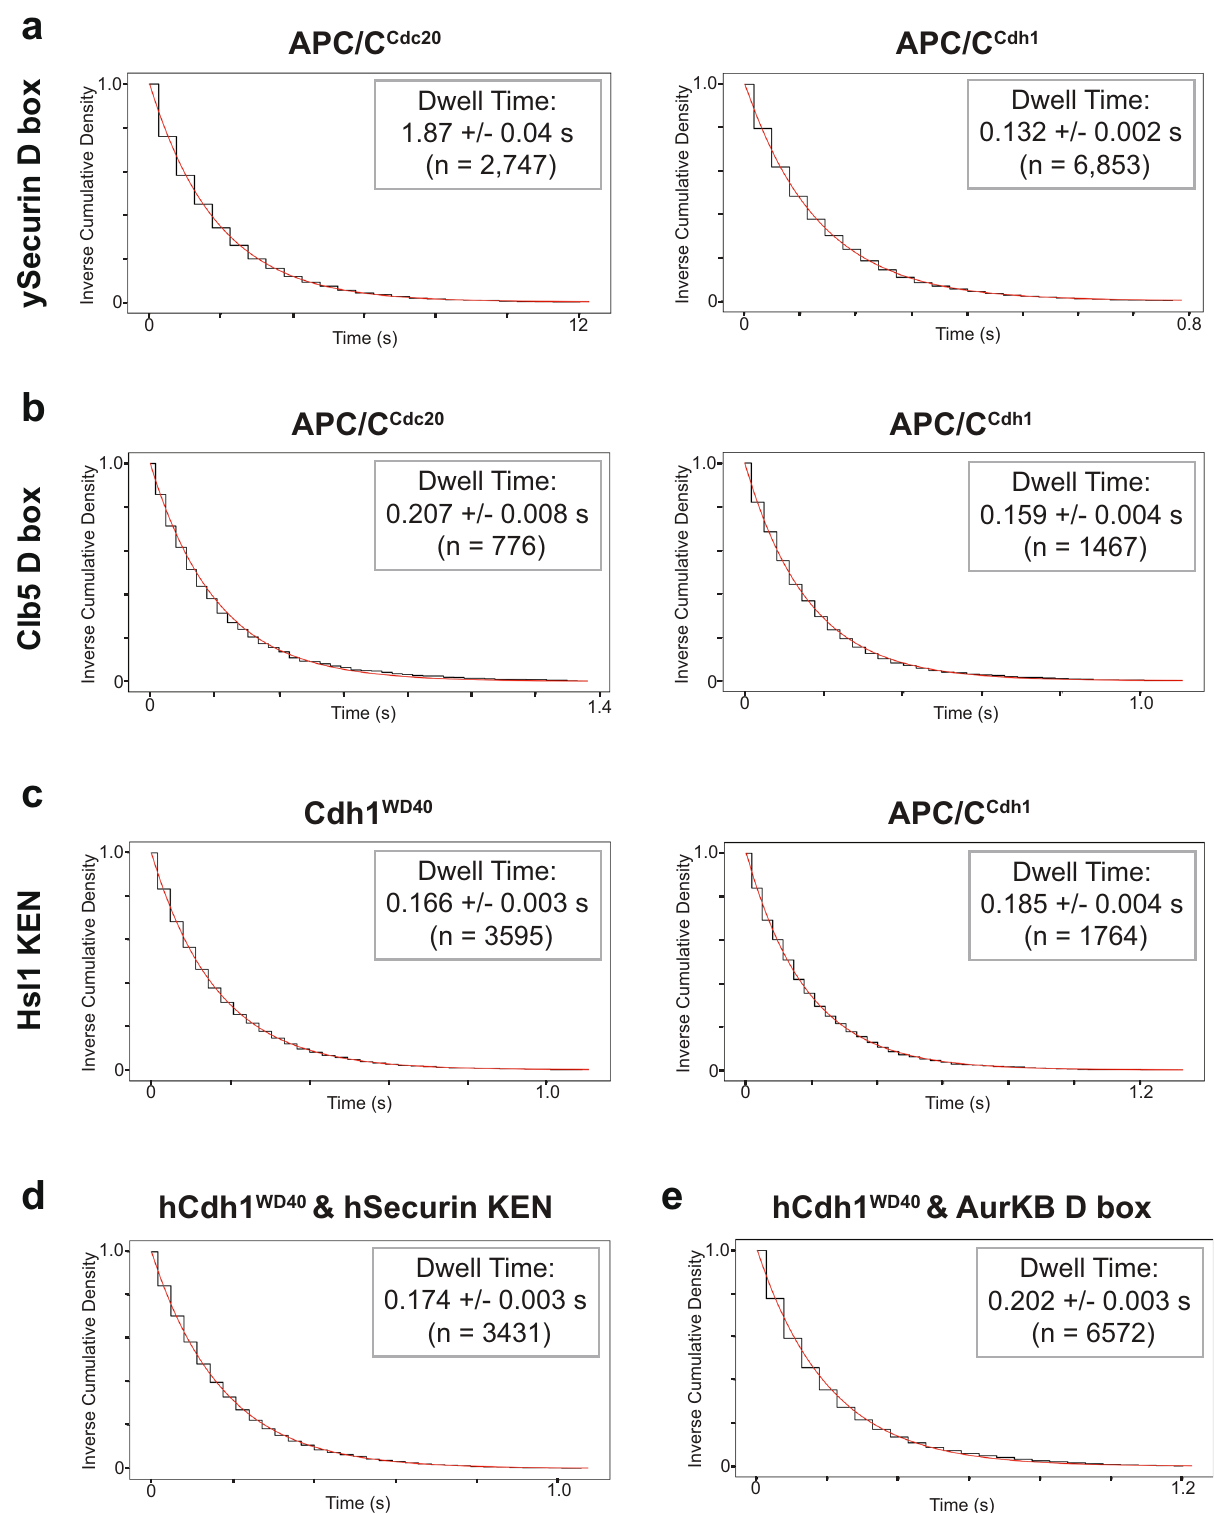
Fig. 5 Analysis of degrons from multiple substrates. a – c Dwell time distributions from SMOR analysis of representative movies with Cy5-labeled ySecurin D box peptide ( a 1 nM), Clb5 D box peptide ( b 1 nM), and Hsl1 KEN peptide ( c 1 nM) binding to the indicated GFP-tagged proteins. d , e Analysis of hSecurin KEN box peptide ( d 500 pM) or AurKB D box peptide ( e 1 nM) binding to GFP-tagged human Cdh1 WD40 domain. Insets indicate mean dwell time ± SE ( n indicates number of selected peaks). Results are representative of two independent experiments (Supplementary Table